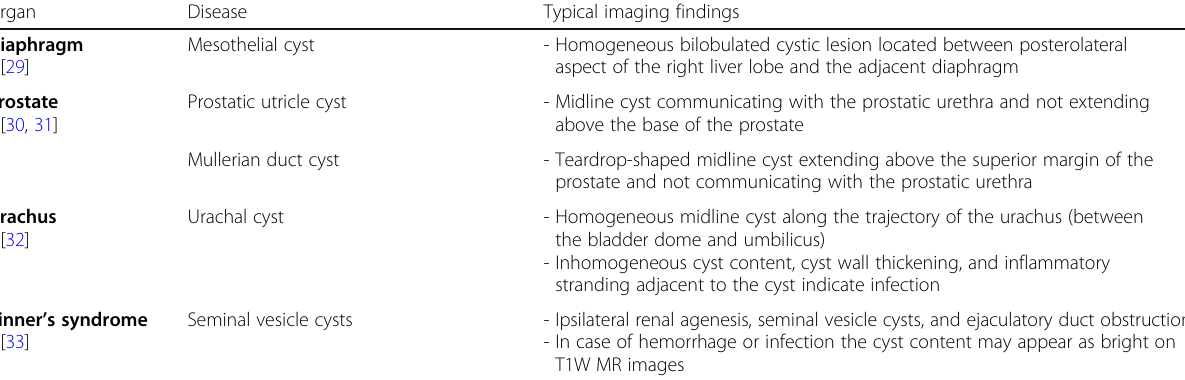
Table 1 Congenital and hereditary cystic diseases of the abdomen. Associated radiological findings. (Continued) Organ Disease Typical imaging findings